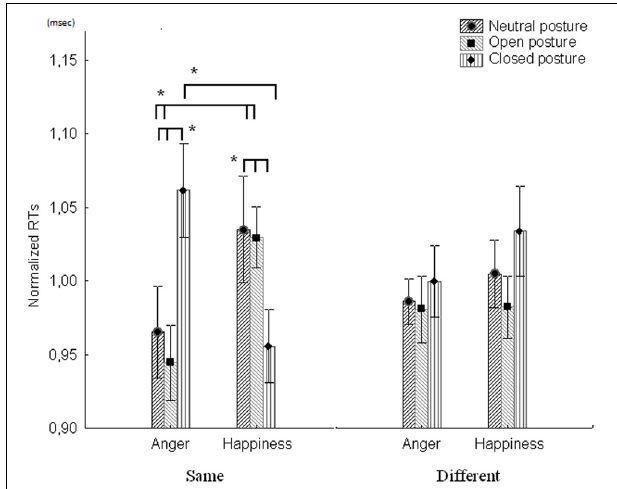
FIGURE 3 | Participants‘ performance in the same/different task. The figure shows RTs (normalized by dividing them with the baseline condition- neutral facial expression) for both angry and happy primes when presented with Neutral, Open or Closed hand postures. The results show a significant difference for the “same” condition (i.e., same), and no significant difference for the “different” condition (i.e., different). ∗ Denotes P- values < 0.05. Vertical bars indicate standard errors of the